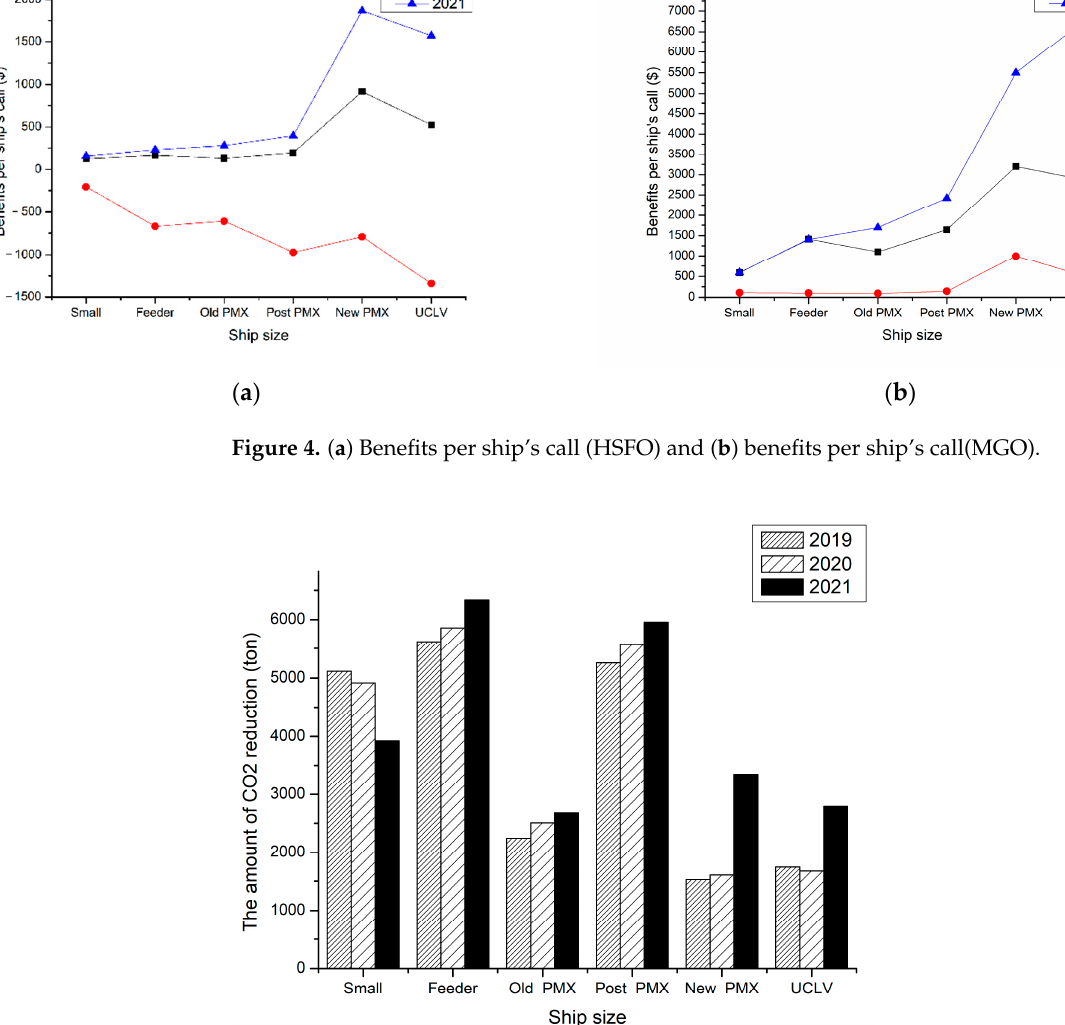
( b ) Figure 6. (a ) Environmental benefit and ( b ) environmental benefit per ship’s call. 4.3. Economic Analysis by Container Size and Fuel Type